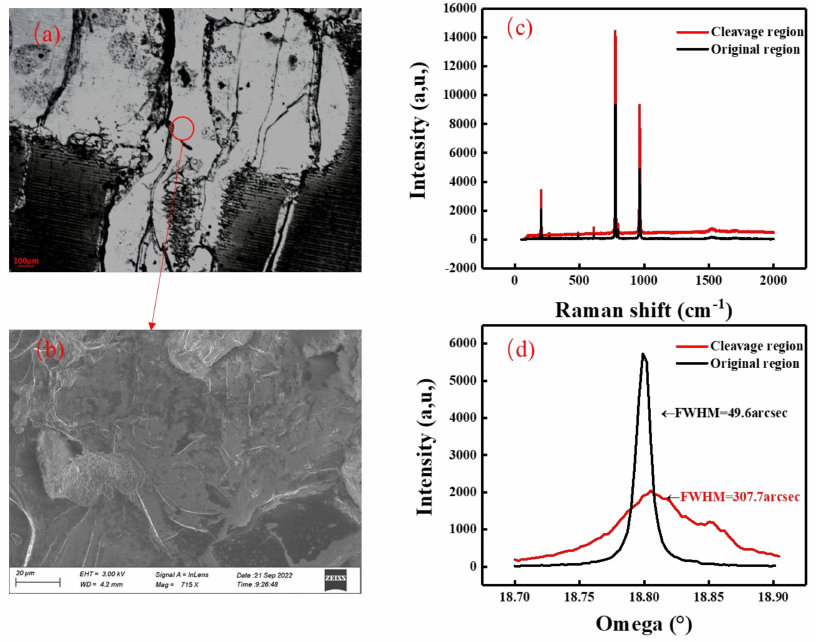
Figure 12. ( a ) The microscopic observation of the cleavage area. ( b ) SEM image of the cleavage area. ( c ) Raman spectrum of the cleavage region. ( d ) X-ray double crystal diffraction rocking curve of the cleavage